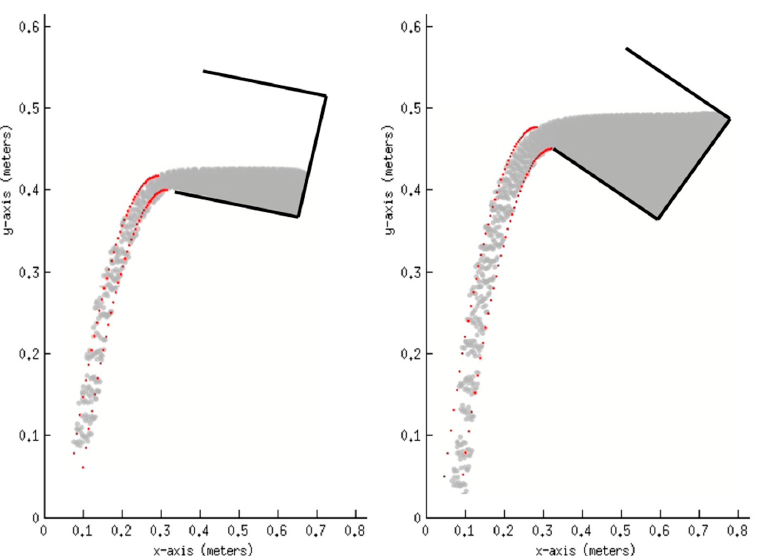
Figure 10. SPH outflows (grey) versus analytic curvatures (red). A narrow outflow to the ( left ). A broad outflow to the ( right ).